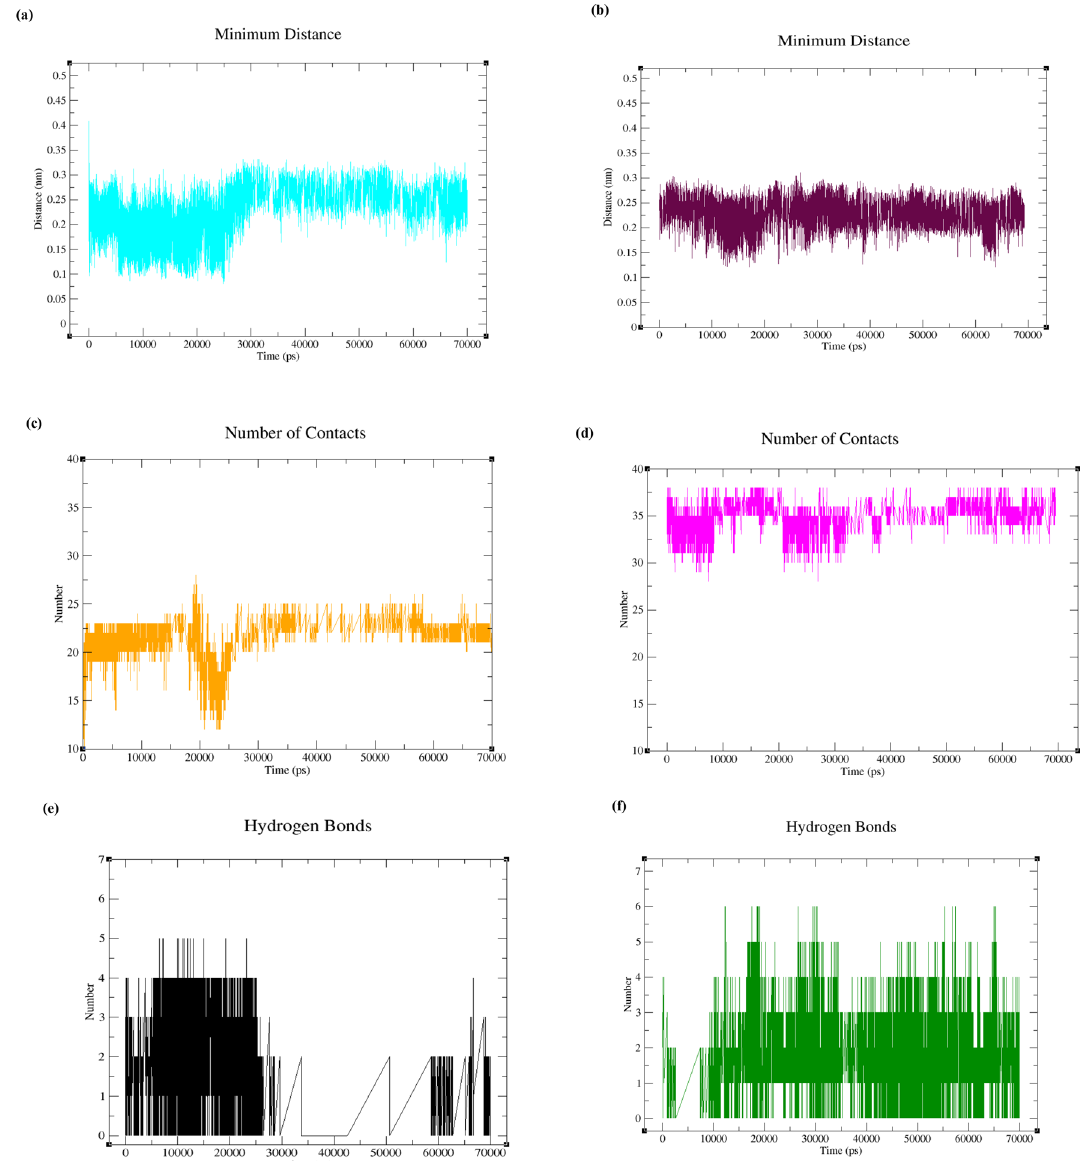
Figure 12. Plots of the DNA backbone complexed with CNP and UNK4 complexes during 70 ns MD simulation: ( a ) plot of average of the minimum distance between DNA and CNP, ( b ) plot of average of the minimum distance between DNA and UNK4, ( c ) plot of number of contacts between DNA and CNP, ( d ) plot of number of contacts between DNA and UNK4. The intermolecular hydrogen-bonding distribution plot versus time for ( e ) DNA–CNP and ( f ) DNA-UNK4.